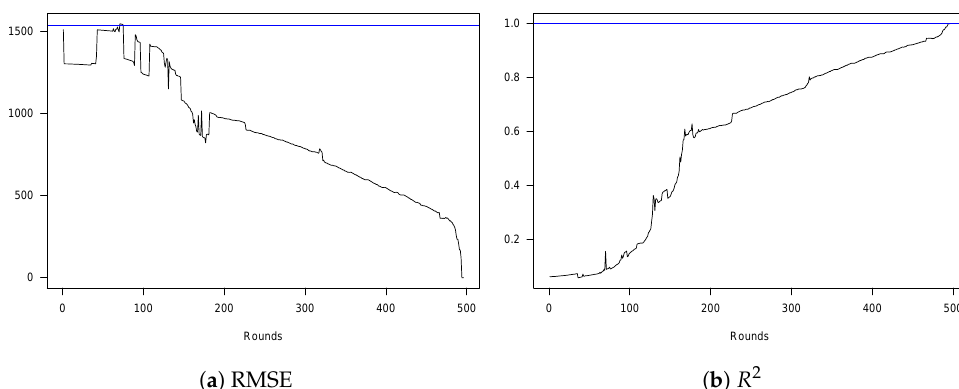
Figure 4. Regression RMSE and R 2 across auction rounds . The graph shows in Panel ( a ) the development of the standard error of the regression residual (RMSE) across the auction rounds. It is measured as the absolute deviation of returns (in percentage points). The blue line indicates the standard error of the dependent variable returns (which are also calculated in percentage terms). In Panel ( b ), the round-by-round evolution of the model R 2 is